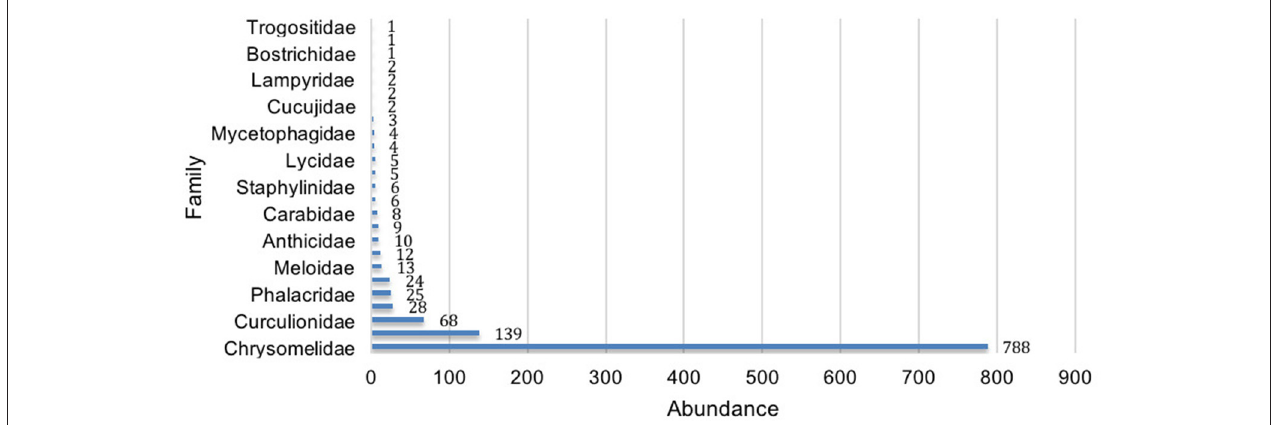
FIGURE 4 | Total abundance of every beetle family identified in the traditional and industrialized management types of maize-based agroecosystems.